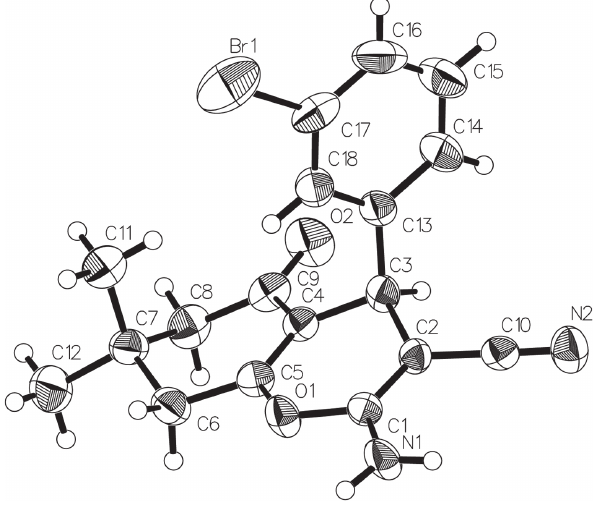
Table 1: Data collection and handling.